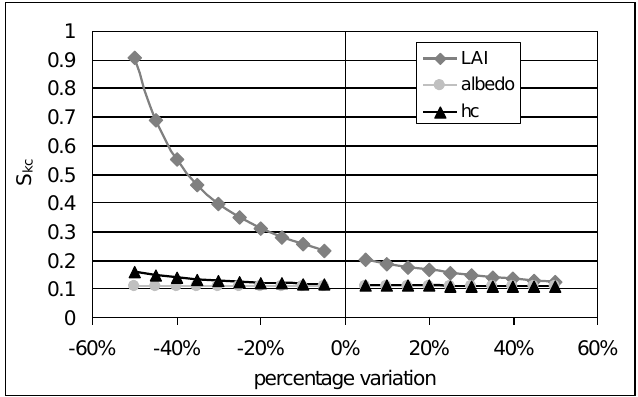
Figure 2. Sensitivity coefficient of kc at LAI, albedo and vegetation height variations.